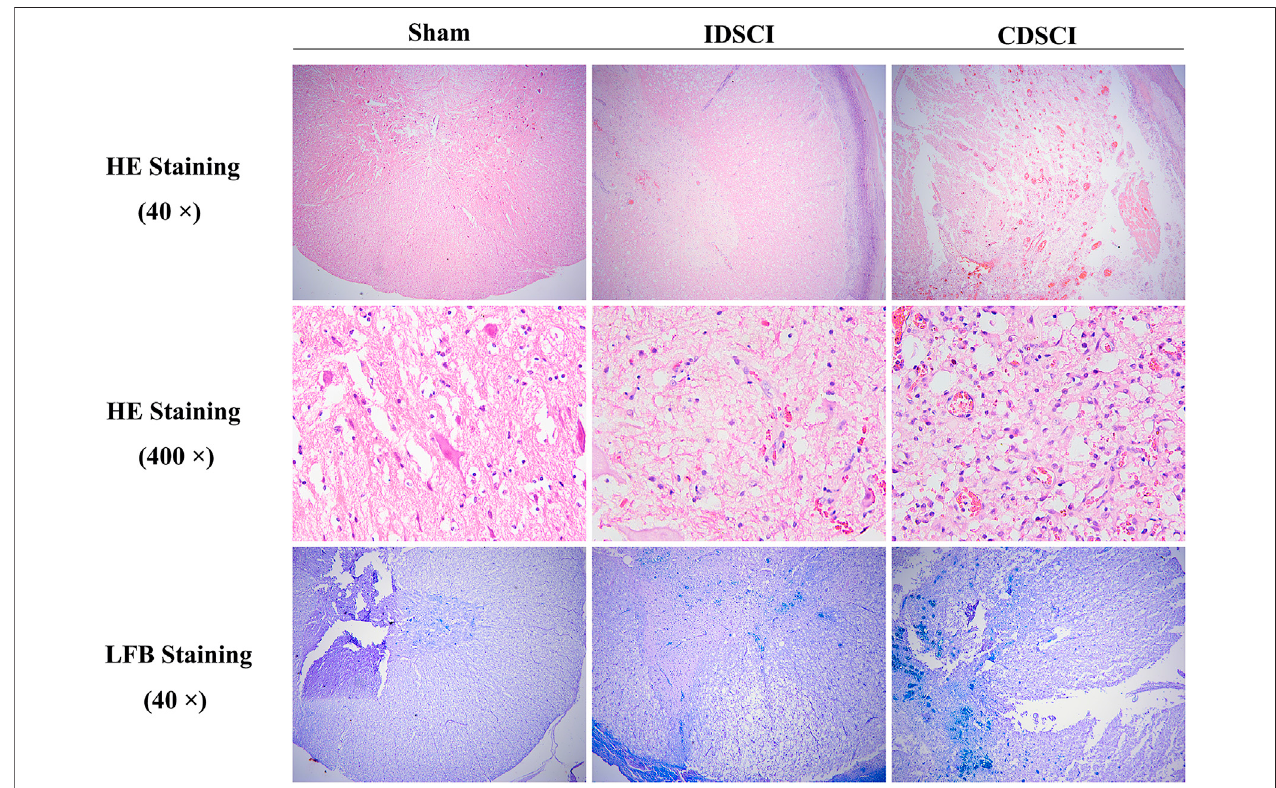
FIGURE 4 | The pathological changes in the spinal cord tissues of different groups following DSCI. The representative images of spinal cord tissues stained with H&E (40 × and 400 ×) and LFB staining (40 ×) were shown.